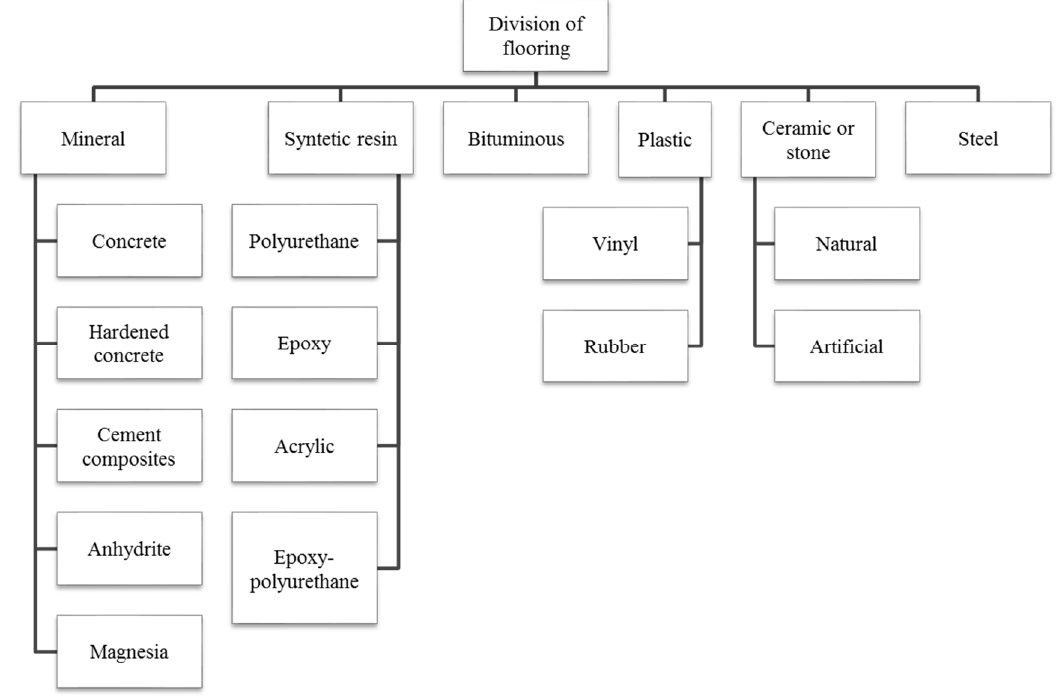
Figure 2. Types of floorings, depending on the material of which they are made (based on Reference [10]).